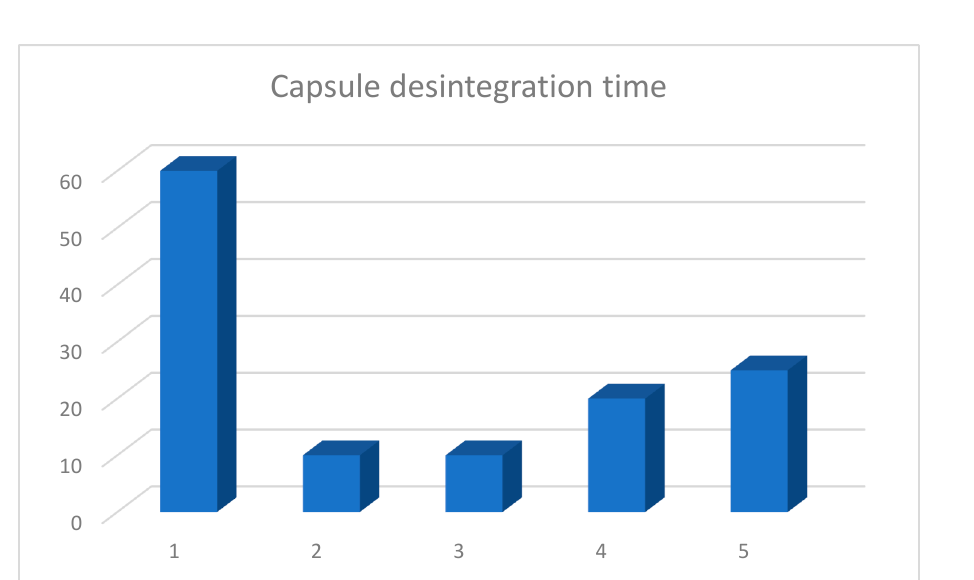
Figure 2. Average disintegration time of capsules containing market products of probiotics. Arith- metic means of three independent